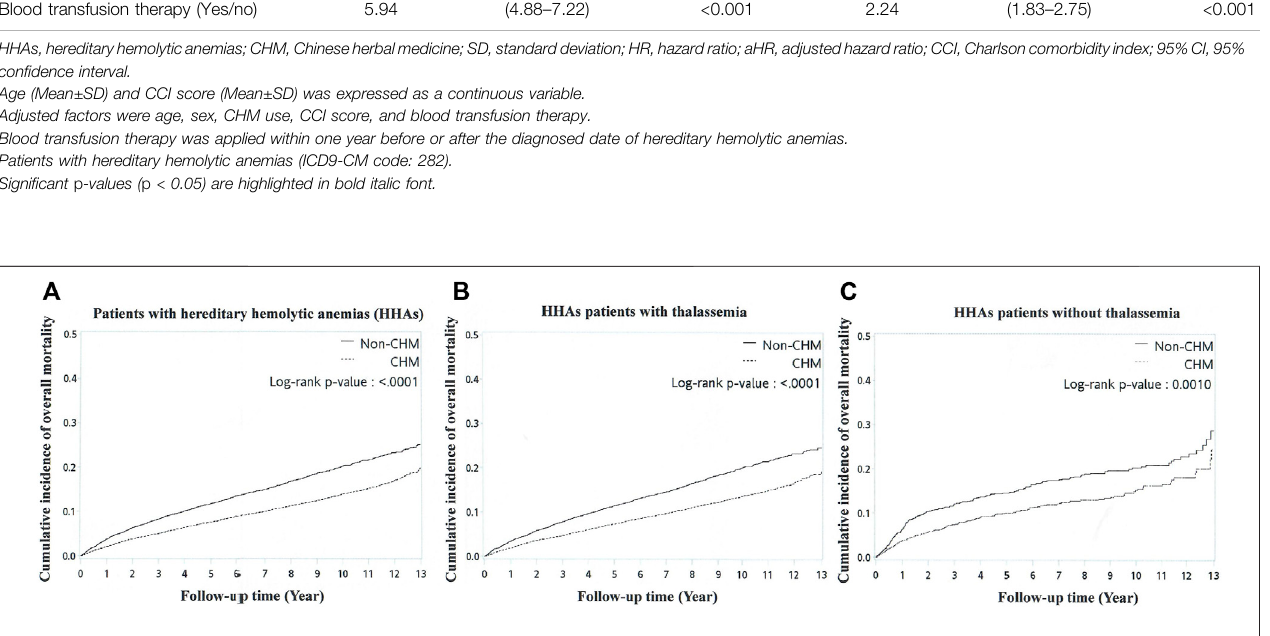
Frontiers in Pharmacology |